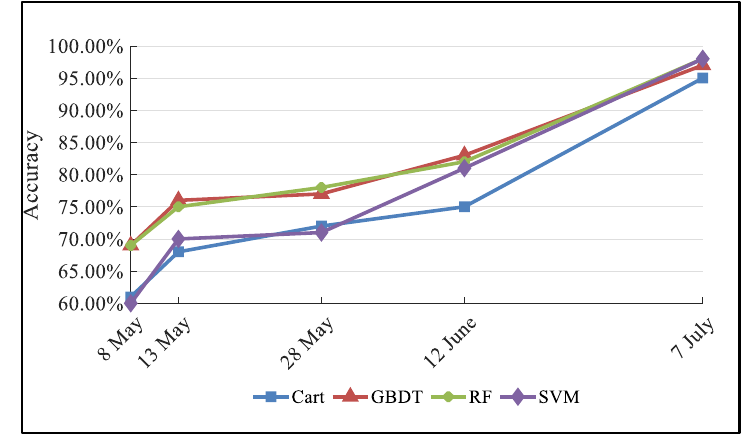
Figure 5. Maximum OA changes of the classifiers in 2020 different periods.